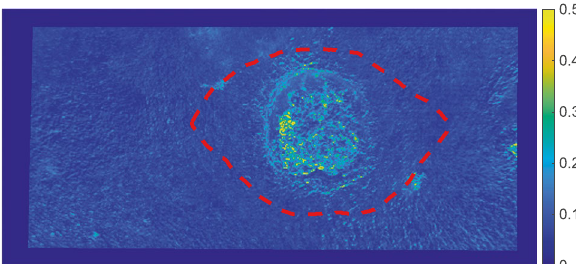
Figure 7. Example of flow chart. Resection mask is shown with red dashed